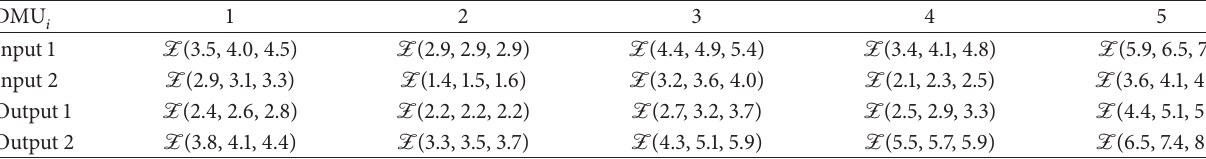
Table 1: DMUs with two uncertain inputs and two uncertain outputs.